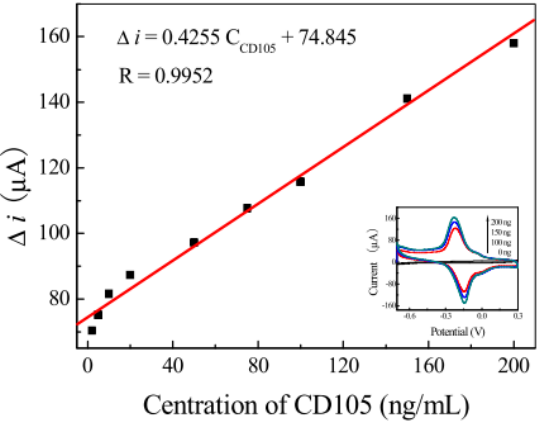
Figure 4. The current responses of the proposed immunosensor to CD105 with different concentrations.